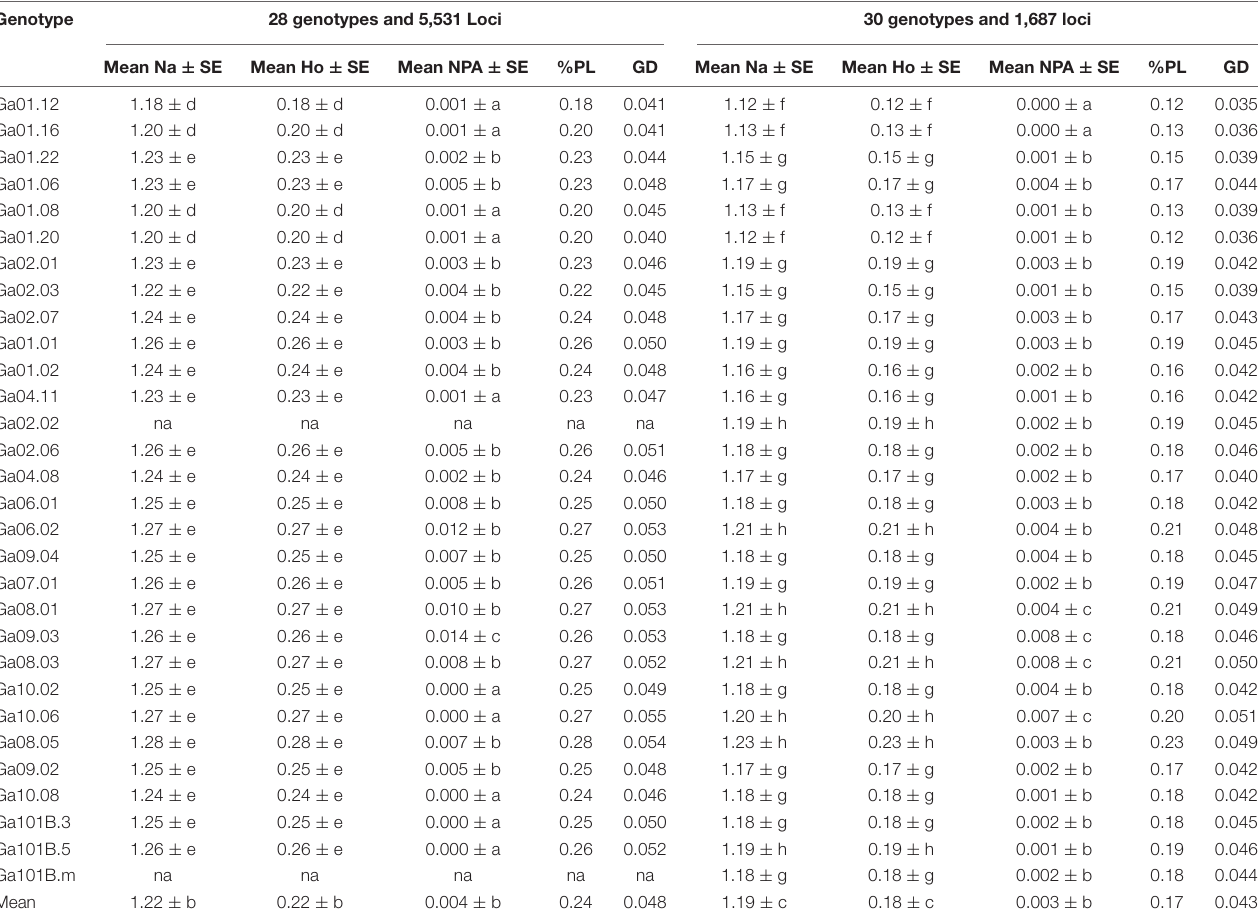
TABLE 2 | Mean values of observed number of alleles (Na), observed heterozygosity (Ho), number of private alleles (NPA), percent polymorphic loci (%PL) for each genotype and Nei’s standard genetic distance (GD) of each genotype from all other genotypes based on data from 5,531 SNP loci (for 28 of the 30 genotypes) and 1,687 loci (for all 30